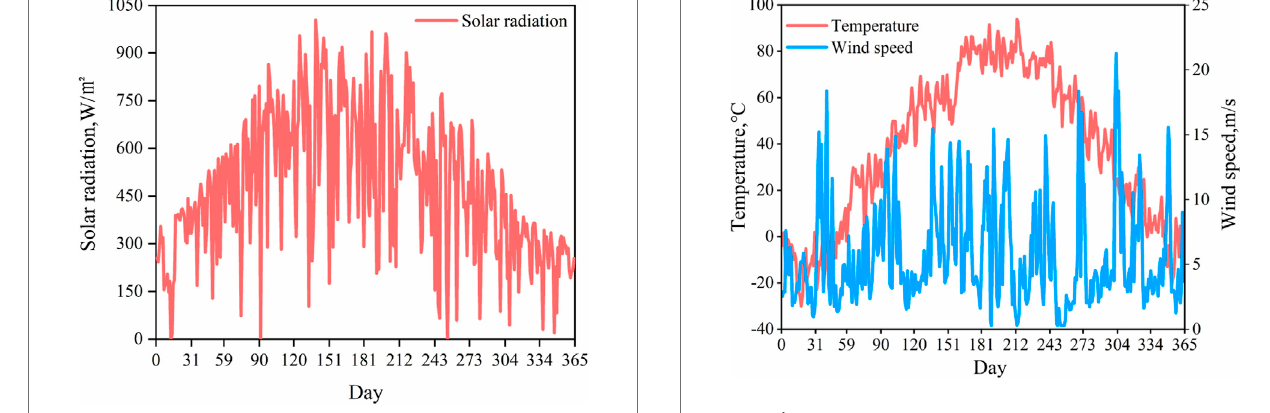
FIGURE 4 | Daily atmosphere temperature and wind speed.